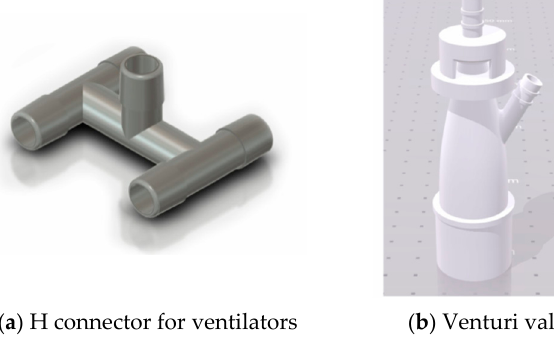
Figure 12. Valves and screens that can be printed using PLA, ABS, or PETG.